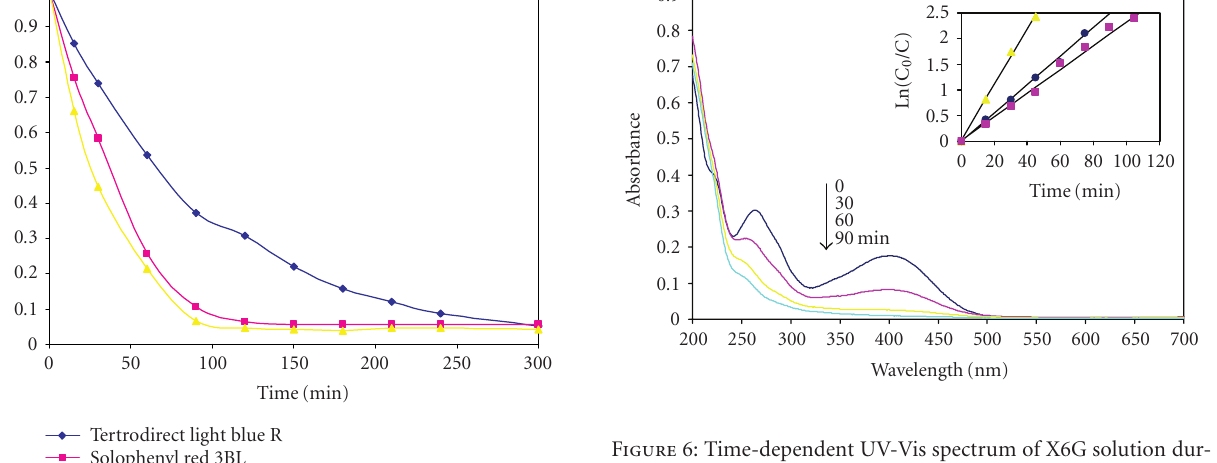
Figure 6: Time-dependent UV-Vis spectrum of X6G solution dur- ing photoirradation on one piece of composite TiO 2 with MC, pH 6 . 00, dye concentration, 10ppm. The inset of the figure shows the kinetic data for this dye in the presence of slurry nanopowder TiO 2 (160 ppm) solution ( (cid:2) ) composite thick film without MC ( (cid:2) ), and composite thick film with MC ( •